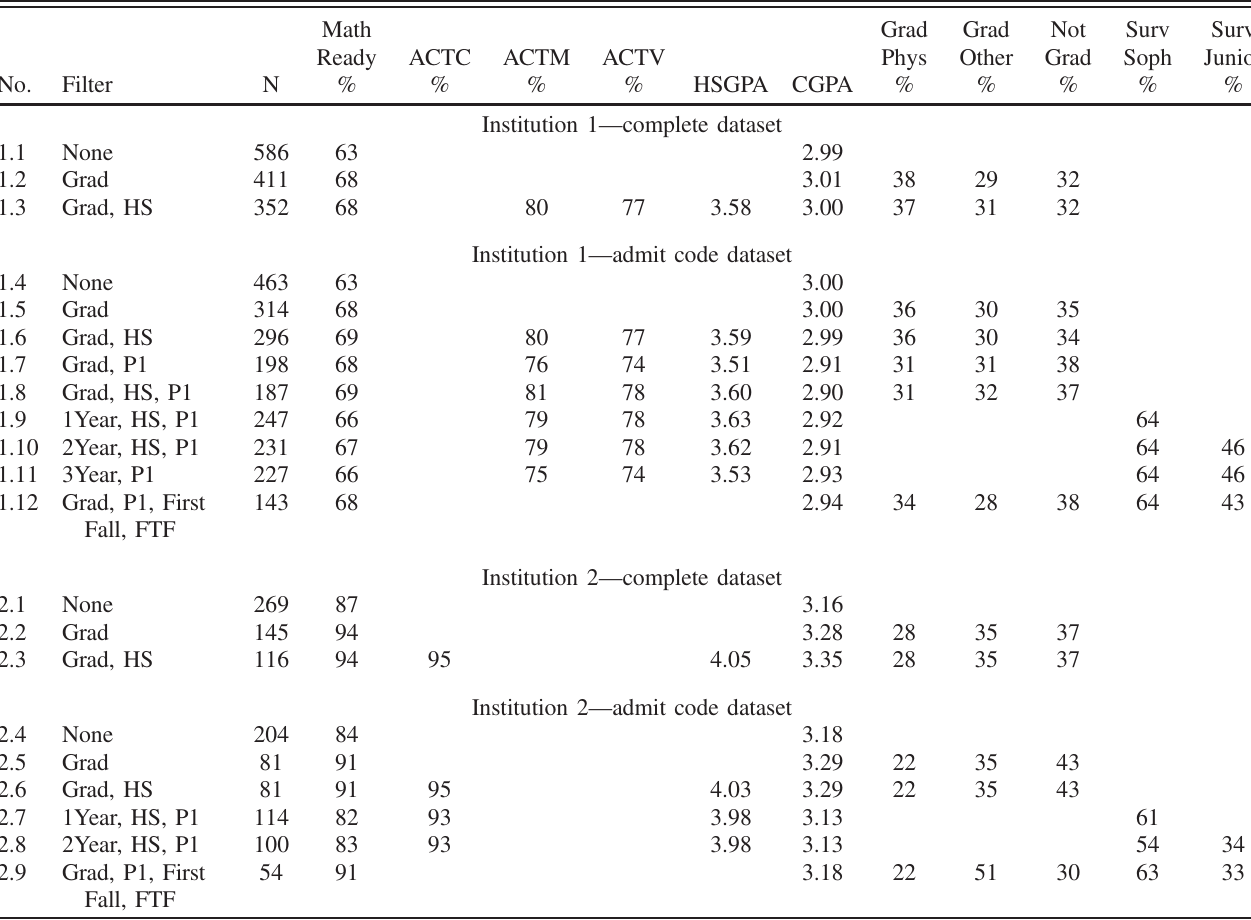
TABLE I. Descriptive statistics applying a variety of filters for Institutions 1 and 2. Filters are abbreviated: HS (high school) for students with HSGPA and ACT or SAT scores, P1 (Physics first) for students whose first declared major is physics, FTF (first-time freshman) students admitted as first-time freshmen, Fall First, students whose first semester was the fall semester. Different windows were also applied to investigate persistence and graduation. Grad (graduation) removes the last six years of records, 1Year (one year) removes the last year of records, 2Year (two year) the last two years, and 3Year (three year) the last three years. Columns are abbreviated ACTC% (ACT composite %), ACTM% (ACT or SAT mathematics %), ACTV% (ACT or SAT verbal %), HSGPA (high school GPA), CGPA (college GPA), Grad Phys % (percentage of student graduating with a physics degree), Grad Other % (percentage of student graduating with a degree other than physics), Not Grad % (percentage of students who do not graduate with any degree), Surv Soph % (percentage of students enrolled as physics majors in their sophomore year), and Surv Junior % (percentage of students enrolled